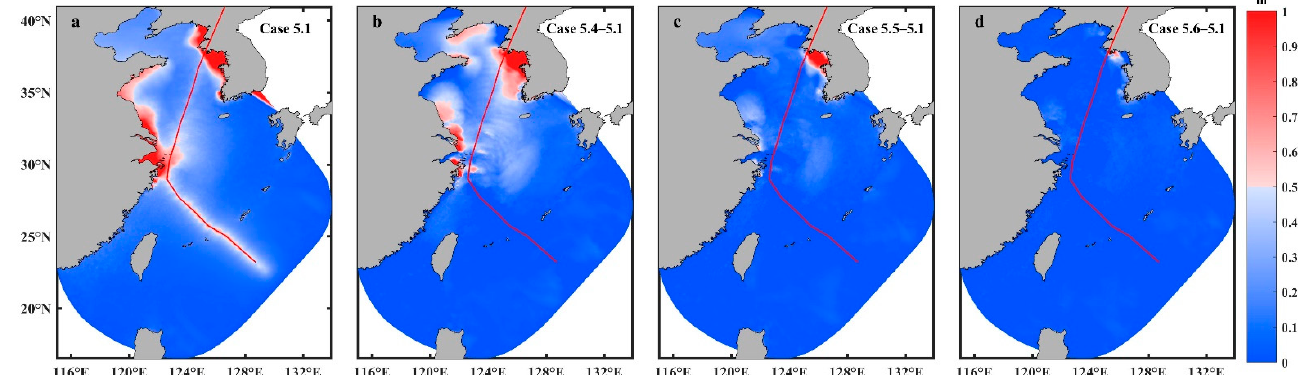
Figure 20. ( a ) Contour plots of peak surges for the simulation of path Chan-hom in Case 5.1, and the red line is the path of Chan-hom; ( b – d ) Contour plots of peak surge differences for the simulation of path Chan-hom between sensitivity experiments and Case 5.1, and the red line is the path of Chan-hom.